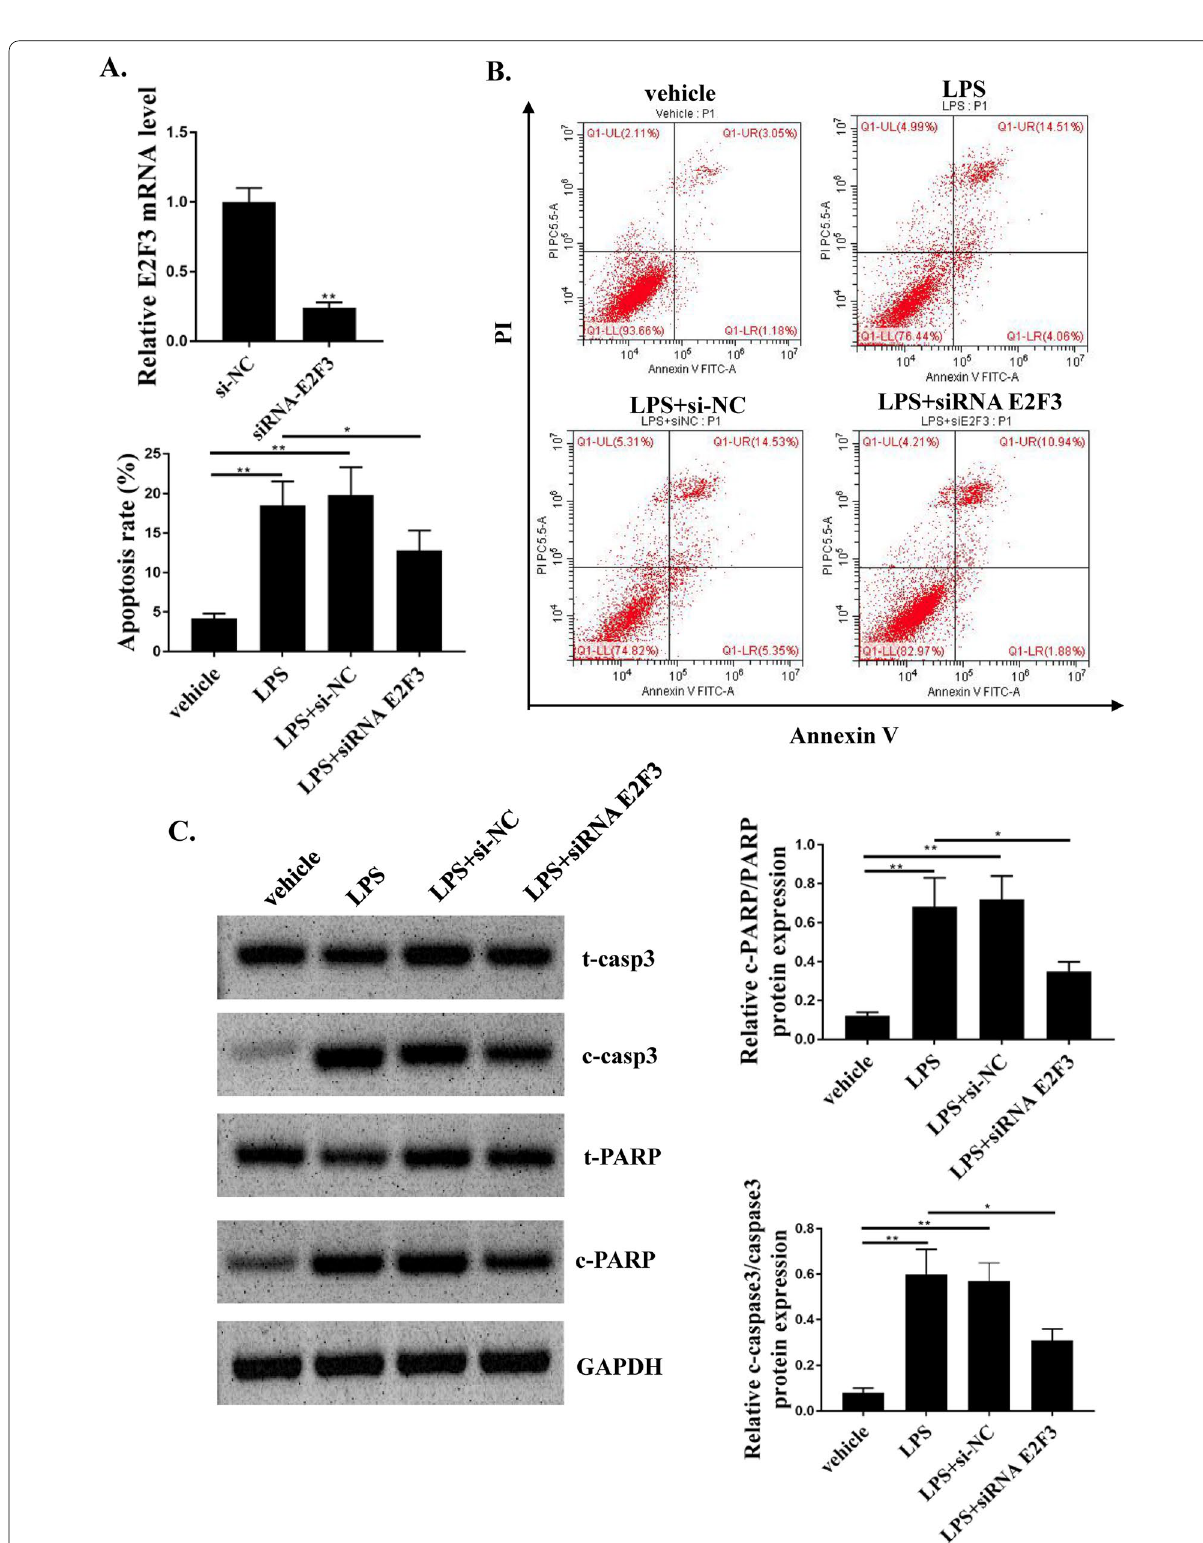
Fig. 7 E2F3 involves in the H9C2 cell apoptosis induced by LPS. A Knockdown of E2F3 in H9C2 cells. B E2F3 knockdown significantly reduced the H9C2 cell apoptosis induced by LPS. C E2F3 knockdown significantly reduced the phosphorylation levels of caspases3 and PARP induced by LPS. *P < 0.05, **P < 0.01, n =